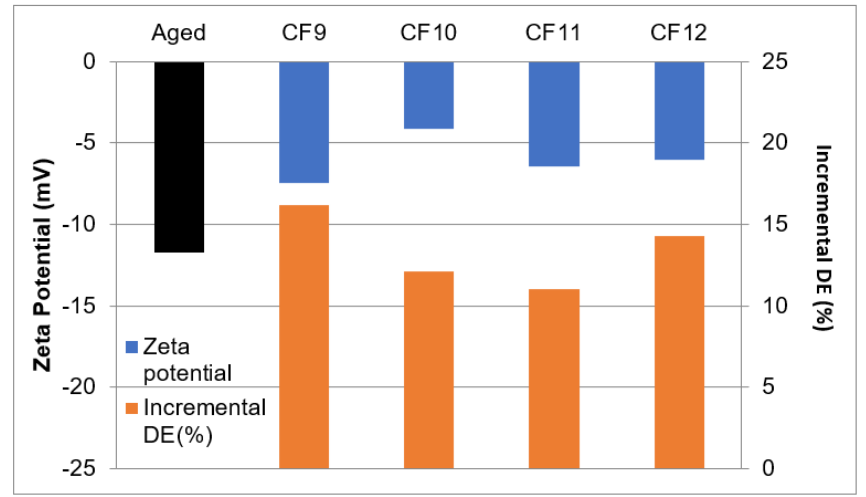
Figure 17. Average zeta potential (pH 3–pH 6) compared to DE (category 3).